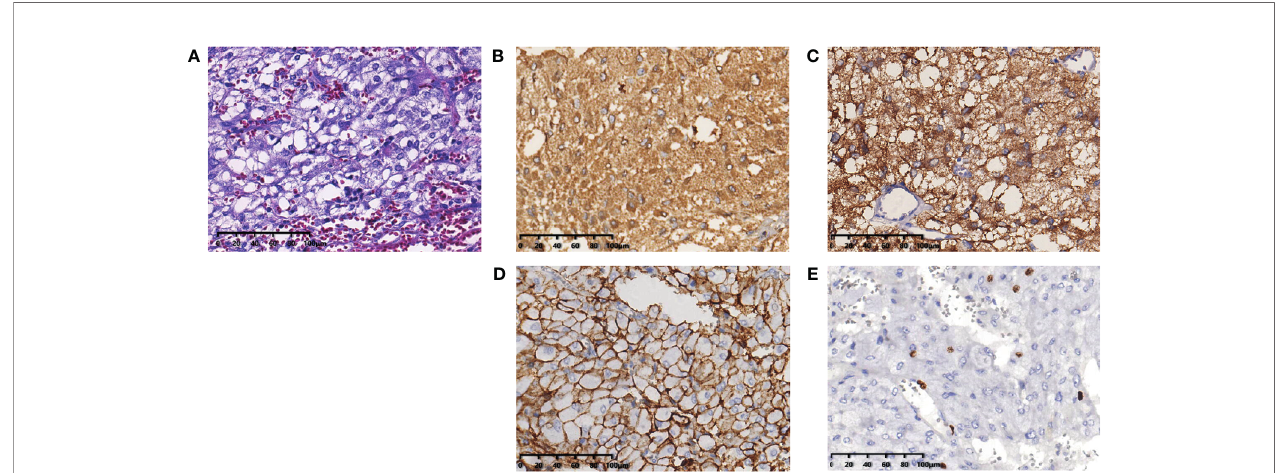
FIGURE 2 | Histopathological examination shows the pulmonary nodules were metastatic pheochromocytoma. (A) Hematoxylin and eosin staining of biopsy specimens shows nests of tumor cells separated by vascular septa (Zellballen). (B) Chromogranin and (C) synaptophysin immunostaining is diffuse strong positive in